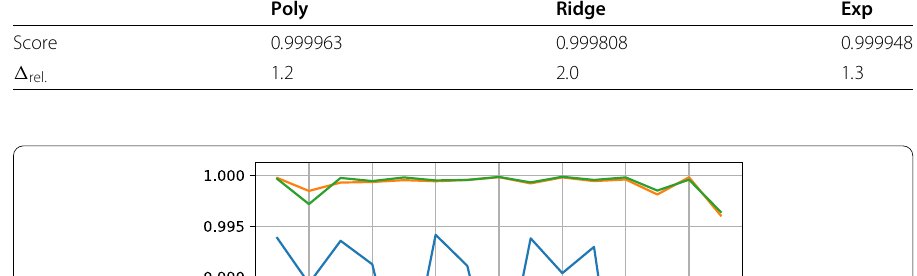
den layers, perceptrons per layer and activation function for a neural network are not straightforward. Some rules of thumb and strategies are described in [8,10]. For this case the tanh -function was selected for activation, as the underlying problem is non-linear with steep gradients. A number of two layers and three perceptrons per layer turned out to be efficient. The model was built and trained using the Tensorflow -package, [11]. The software reported a total number of 34 trainable parameters for the whole network. The NN-Regularization was kept fix to a value of α = 0 . 001 and no further tuning of NN-Model parameters was